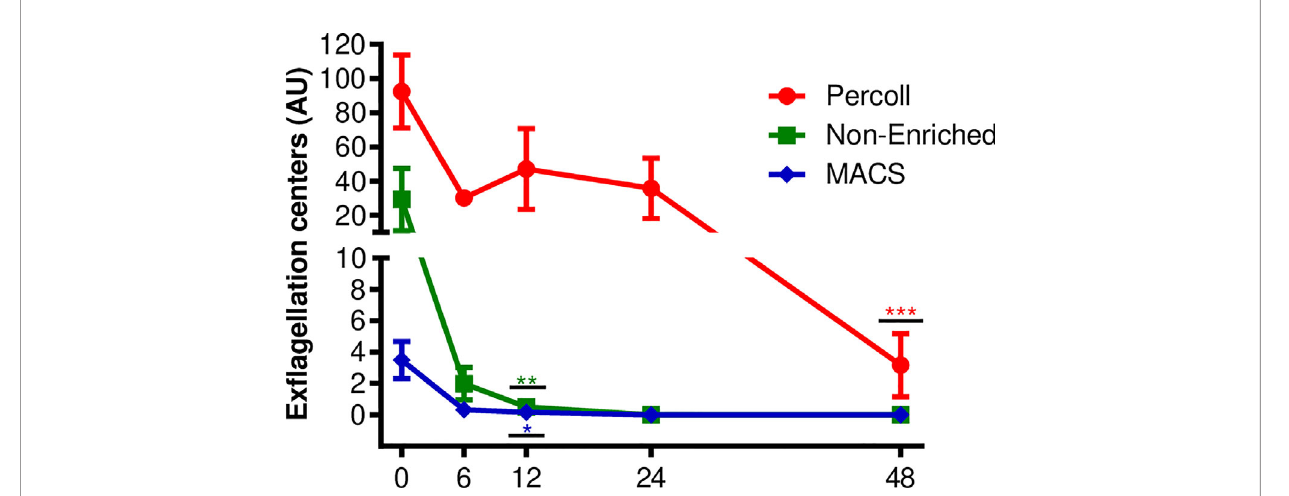
FIGURE 2 | Viability by ex fl agellation assay. Number of ex fl agellation centers formed in P. vivax culture after Percoll 70% or MACS enriched processes and non- enriched samples. Each point represents the average number of ex fl agellation centers counted at each time interval, vertical lines represent the standard error. Data are from six independent experiments. Asterisks *p <0.05, **p <0.01, ***p <0.001 represent signi fi cant differences (using one-way ANOVA) compared to the control (0